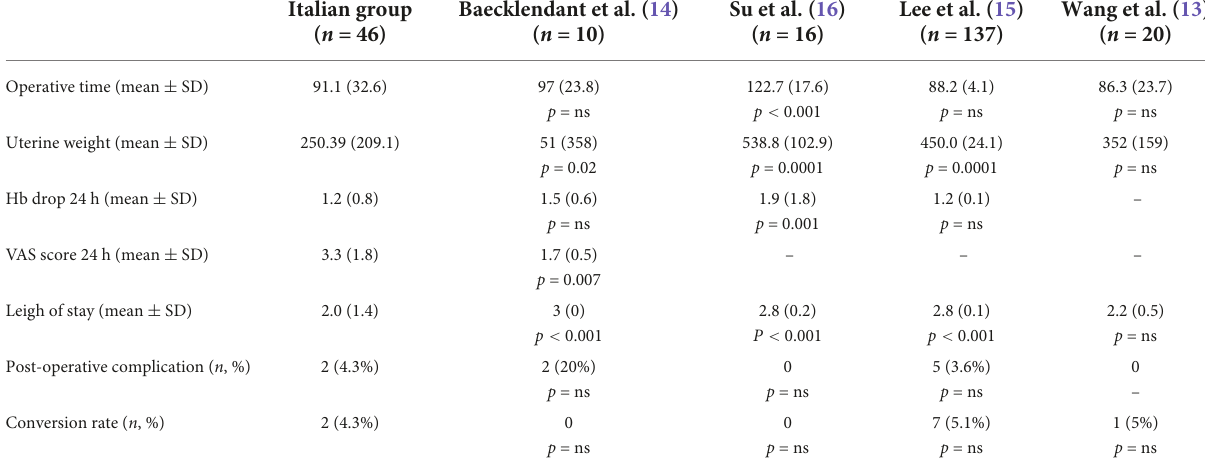
TABLE 2 Perioperative and post-operative outcome of vNOTES in our case series, and comparison with previous studies by Beakelant et al. (14), Su et al. (16), Lee et al. (15), and Wang et al. (13). Italian group ( n =